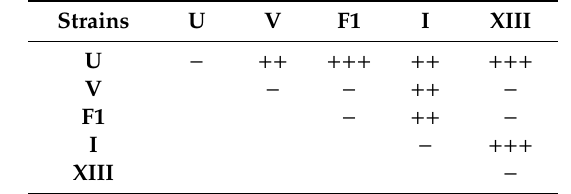
Table 1. Mating interactions between strains used in this study. For each cell combination, the intensity of mating interactions is indicated, from absent ( − ), 40% ( ++ ), to more than 70% ( +++ ). Strains U V F1 I XIII U − ++ +++ ++ +++ V − − ++ − F1 − ++ − I − +++ XIII